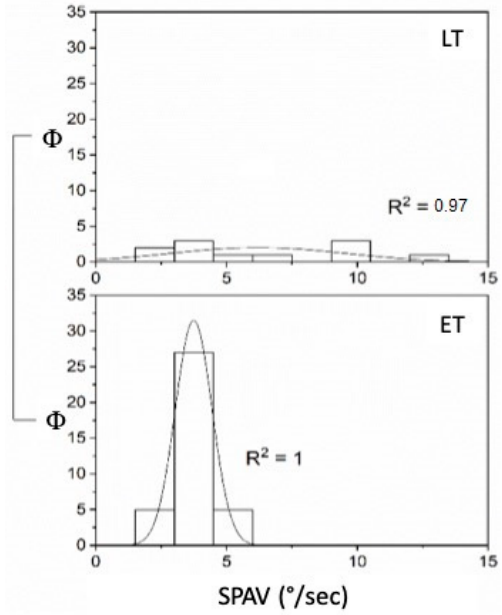
Figure 4. SPAV (°/s) of spontaneous Ny in compensated (LT) and uncompensated (ET) UPVL patients ( Φ = data distribution frequency). The Gaussian peak represents the mean of SPAV frequency in °/s. Normal curve fit R 2 = 0.99 for all ( p = 0.001).